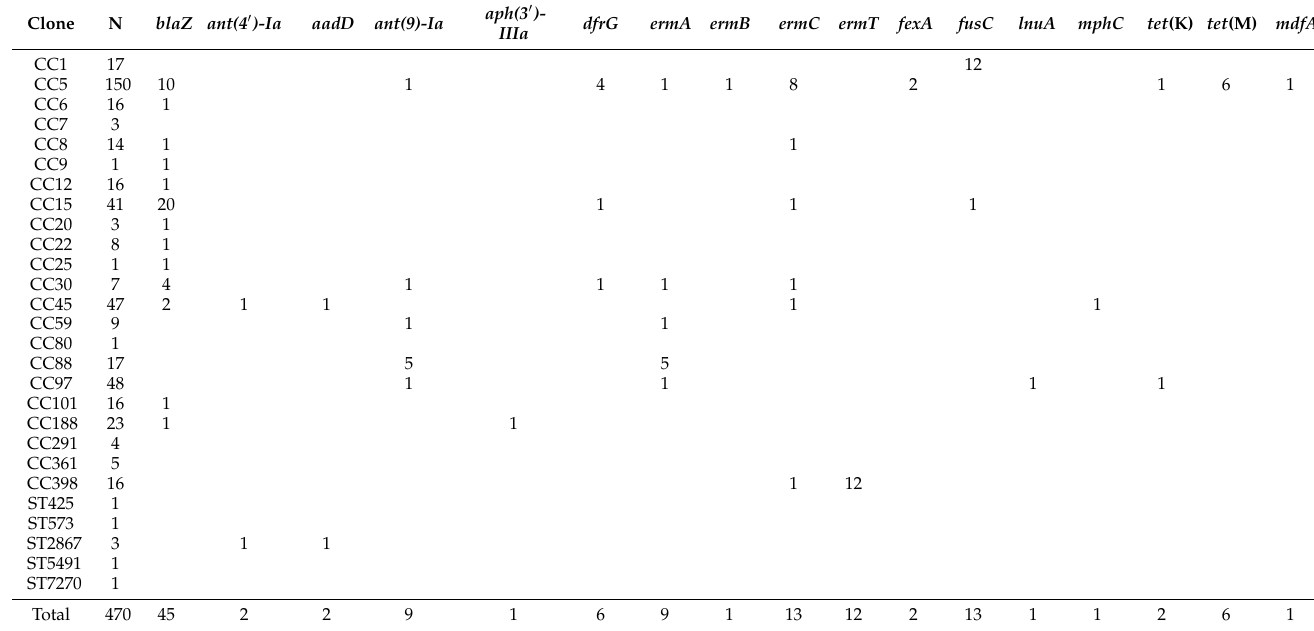
Table 2. The prevalence of antimicrobial resistance genes detected by whole genome sequencing in 470 penicillin-susceptible Staphylococcus aureus with different clonal